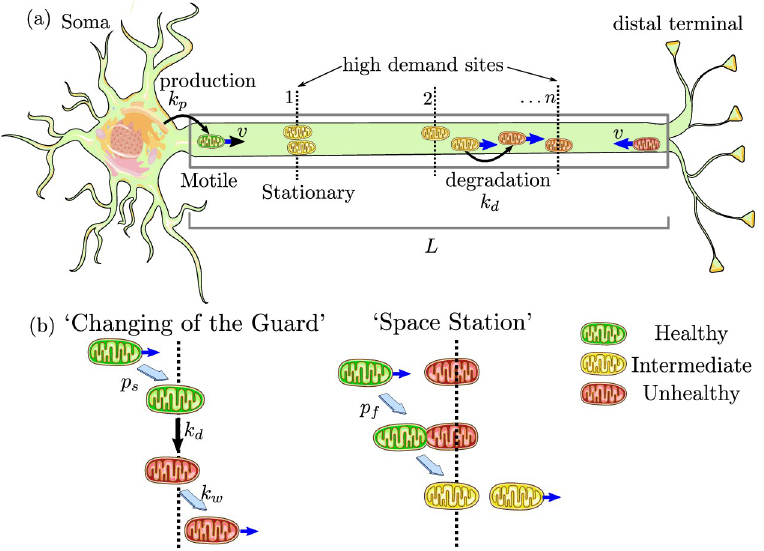
Fig 1. Schematic of quantitative models for mitochondrial maintenance in long neuronal projections. (a) Mitochondria are produced at the soma at rate k , move processively with velocity v , and can stop at one of n discrete p sites with high metabolic demand. Mitochondrial health degrades continuously with rate k d . Gray box represents the modeled linear domain of length L . (b) Two models for mitochondrial exchange at demand sites. In the CoG model, stationary mitochondria re-enter the motile population with rate k w while passing motile mitochondria stop with probability p . Stopping and restarting rates are independent of mitochondrial health; on average, however, restarting s mitochondria will be less healthy than when they first stopped at the site, due to degradation in the stationary state. In the SS model, transient fusion events occur with probability p f each time a motile mitochondrion passes a permanently stationary one [53].